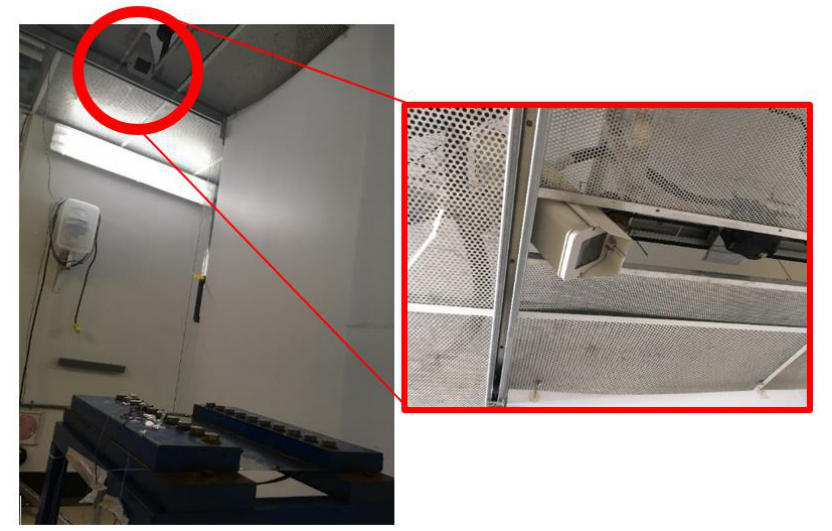
Figure 9. Camera installed over flat plate setup.